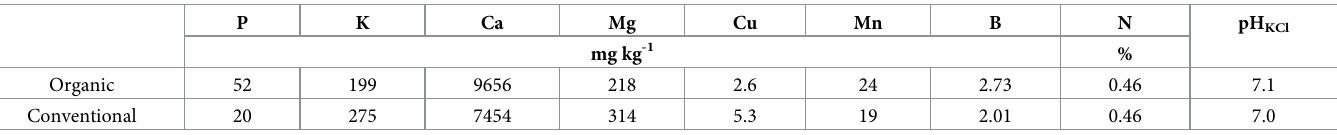
Table 2. The properties of soil mixtures collected from organically and conventionally managed arable fields. P